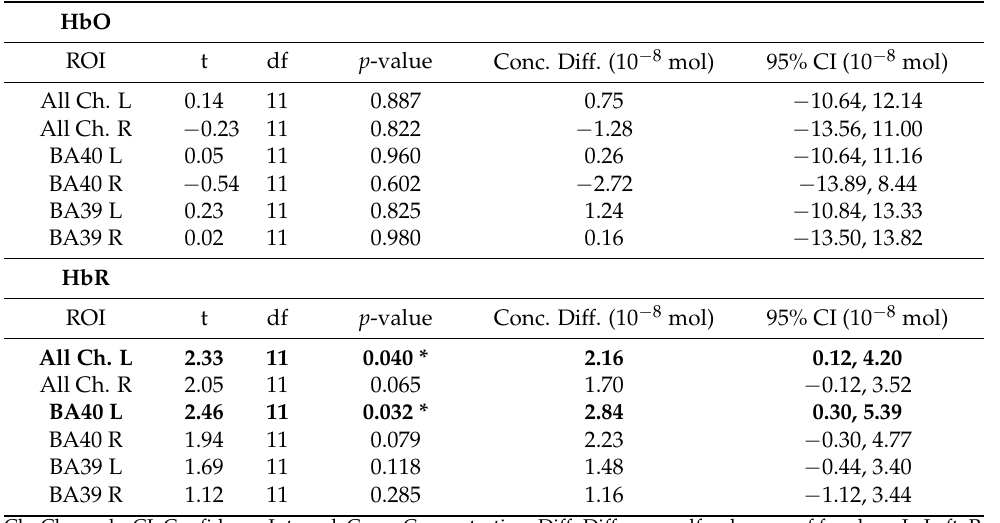
Table 1. Region of Interest HbO and HbR average concentration differences between nGVS and sham